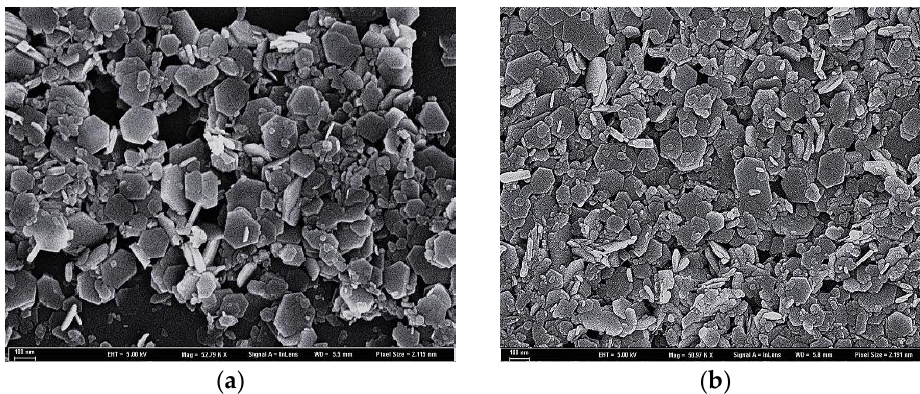
Figure 7. SEM images of the products of hydration in the ultrasound field at 120 min: ( a ) Δn Cl− = 21.5 mol/kg; ( b ) Δn Cl− = 7.5 mol/kg.